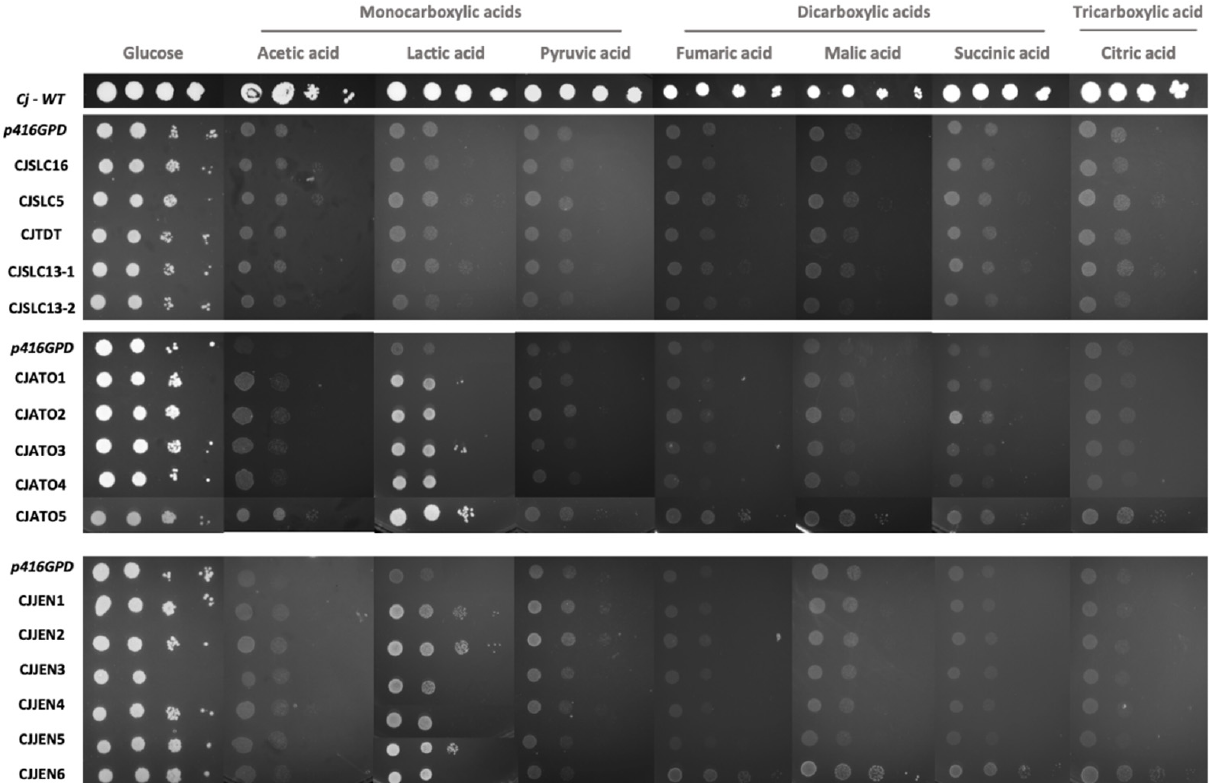
Figure 3. Transport of radiolabeled carboxylates in C. jadinii DSM2361 strain ( A – C ), S. cerevisiae jen1 Δ ato1 Δ ( A , B ), and IMX1000 ( C ) cells expressing the C. jadinii CjATO1-5, CjJEN1-6, CjSLC16, CjSLC5, CjTDT, CjSLC13-1, and CjSLC13-2 proteins, as well as an empty vector (p ɸ ), as negative control. ( A ) Uptake of 1 mM of 14 C-acetic acid (pH 6.0), 14 C-lactic acid (pH 5.0), and 14 C-succinic (pH 5.0) acid. For acetic and lactic acid uptake, a value of 100% (C+) corresponds to the uptake in S. cerevisiae cells transformed with the plasmid p416GPD-expressing genes encoding the native transporters ATO1 and JEN1 , respectively. For succinic acid, a value of 100% (C+) corresponds to isogenic cells expressing the Candida albicans JEN2 transporter cloned in the p416GPD plasmid. ( B ) Uptake of 1 mM 14 C-acetic acid (pH 6.0) and 1 mM 14 C- lactic acid (pH 5.0). A value of 100% corresponds to the uptake of acetic and lactic acid displayed by cells expressing the JEN1 transporter. ( C ) Uptake of 1 mM of 14 C-acetic acid (pH 6.0). A value 100% corresponds to the uptake of acetic acid by C. jadinii DSM 2361 cells. Cells were grown on YNB Glucose, washed, and incubated